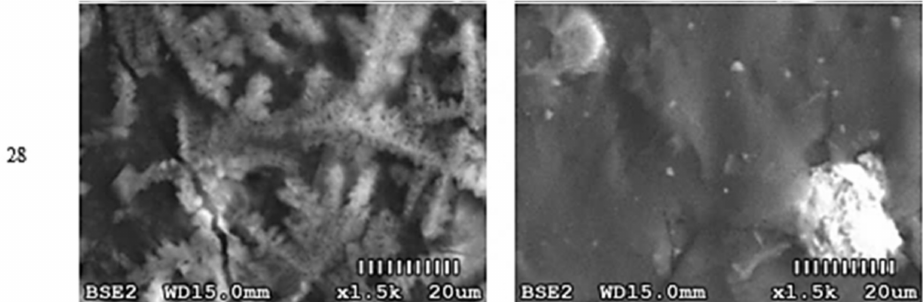
Figure 2. Morphological changes on the surface of PEEK GRF30 immersed in Simulated Body Fluid (SBF) and Hank’s Balanced Salt Solution (HBSS) after selected time periods.